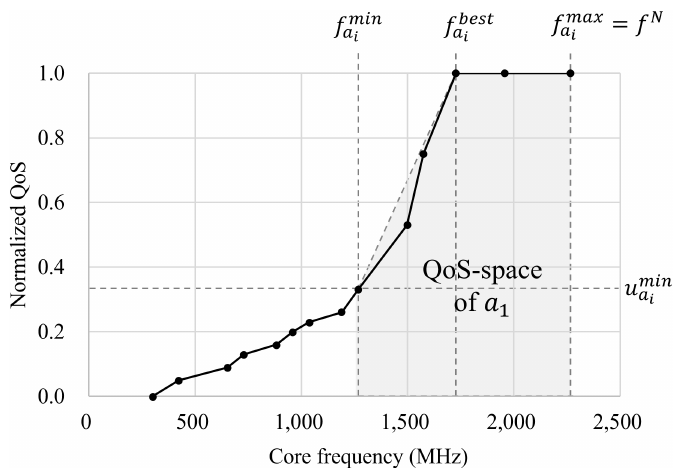
Figure 14. Example of QoS function and its